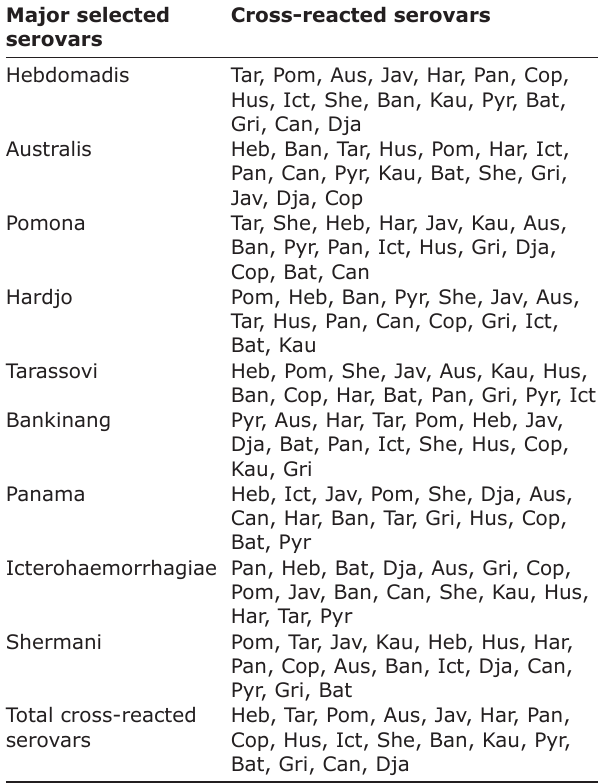
Table-4: Majorly selected reacted serovars versus cross-reacted serovars. Major selected